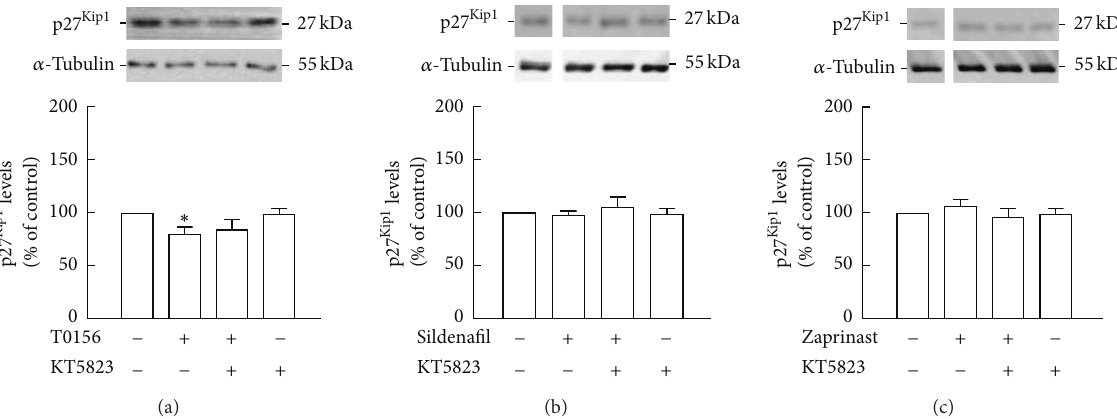
Figure 9: Inhibition of PKG did not prevent the decrease of p2 7 Kip 1 levels by T0156. p2 7 Kip 1 levels following treatment with 1 𝜇 M KT5823 and 1 𝜇 M T0156 (a), 1 𝜇 M sildenafil (b), or 10 𝜇 M zaprinast (c) for 2 h were assessed by Western blot. Representative images are shown. Data are expressed as means ± SEM of at least 4 independent experiments. One-way ANOVA (Bonferroni’s post-test), ∗ 𝑃 < 0.05 , significantly different from